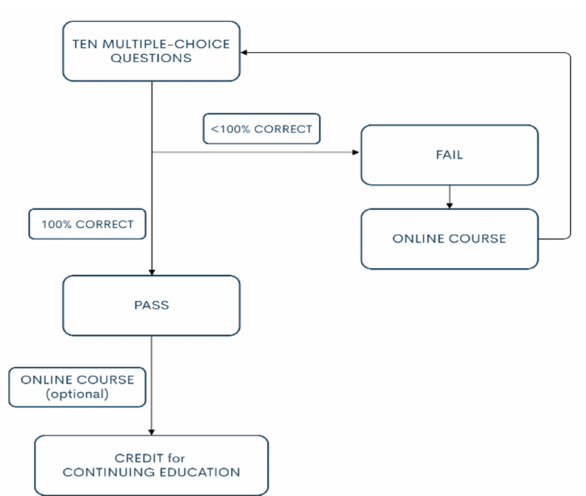
Figure 1. The steps for passing ten online multiple-choice questions about coronavirus disease 2019 (COVID-19).